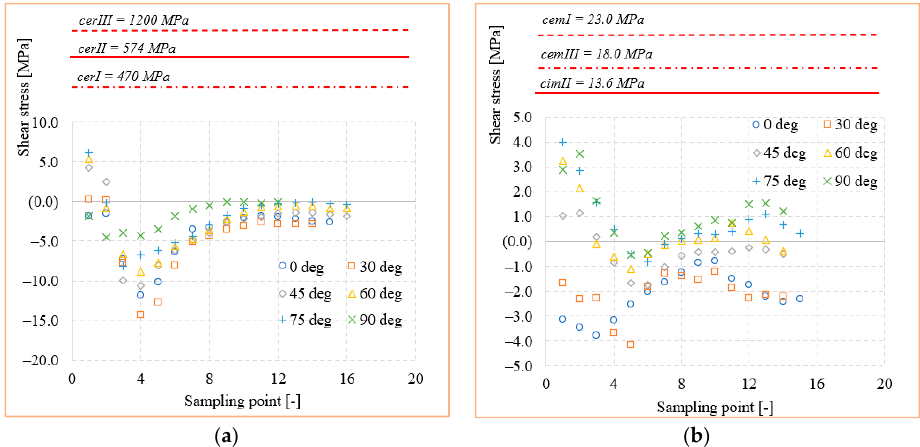
Figure 17. Mechanical strength of dental materials and shear stresses recorded at interface: ( a ) ceramic; ( b ) adhesive cement.